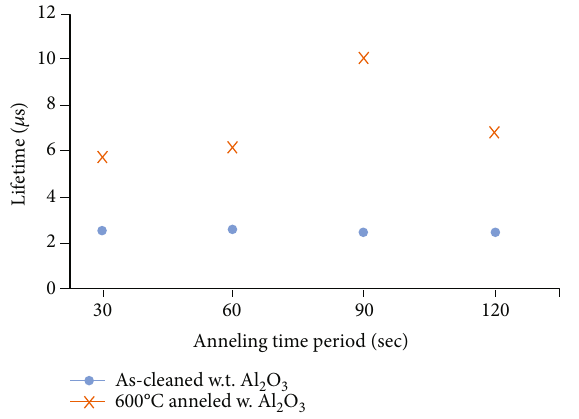
Figure 9: Lifetimes of textured wafers annealed at 600 ° C for various annealing time periods.